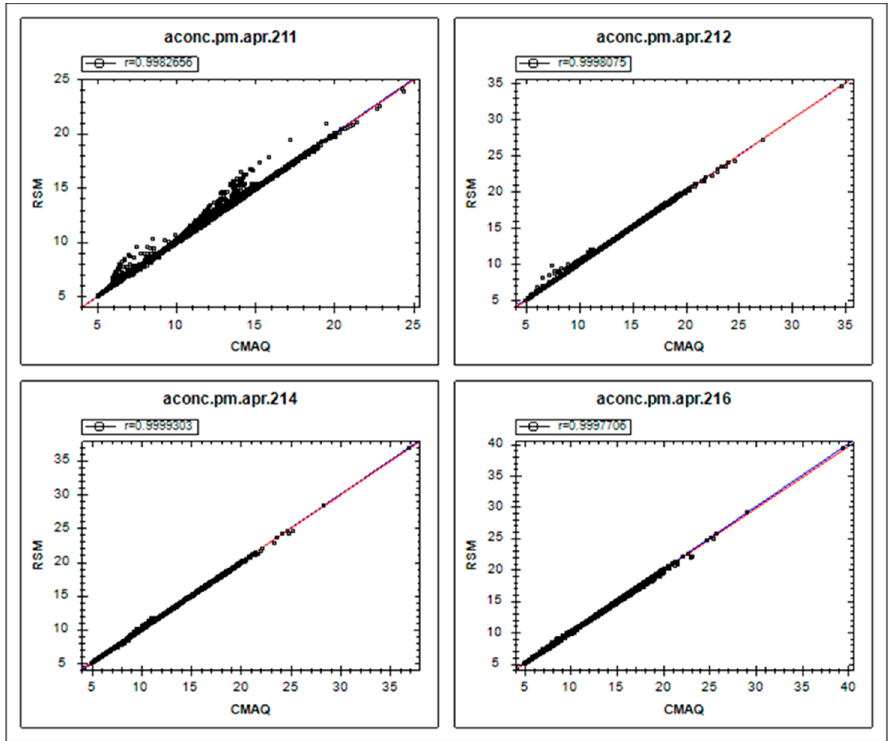
Figure 2. Simulation of PM 2.5 pollution in 2013 by the advance response surface model (RSM) system and Community Multi-scale Air Quality model (CMAQ).